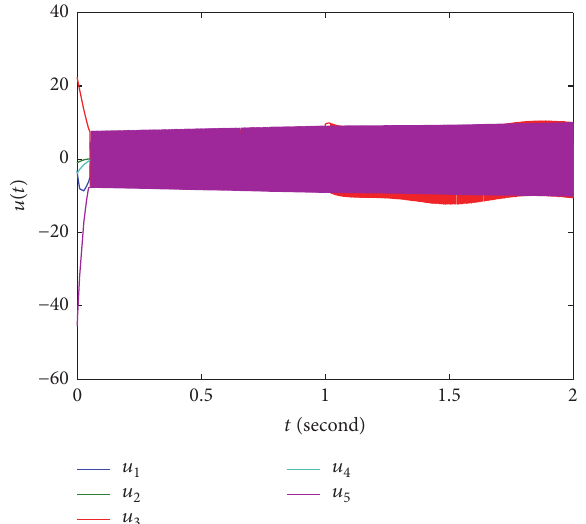
Figure 7: Time response of the input controller 𝑢 𝑖 (𝑡) .